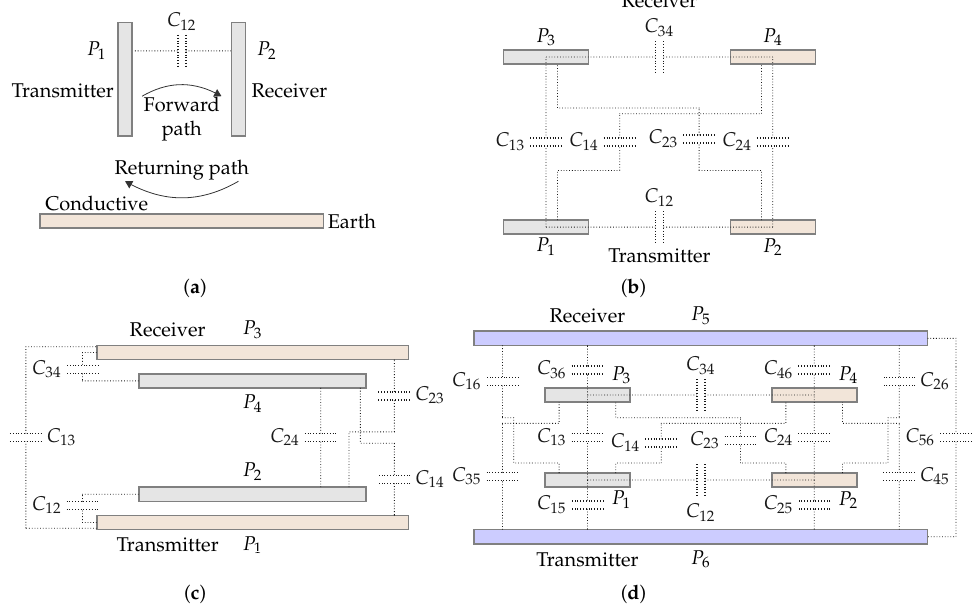
Figure 14. CPT structures: ( a ) two-plate, ( b ) four-plate parallel, ( c ) four-plate stacked, and ( d ) six-plate